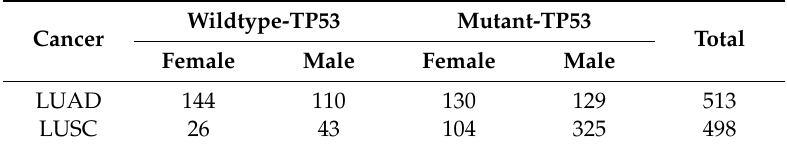
Table 1. TCGA patient samples for lung adenocarcinoma (LUAD) and lung squamous cell carcinoma (LUSC) listed according to patient sex and TP53 mutation